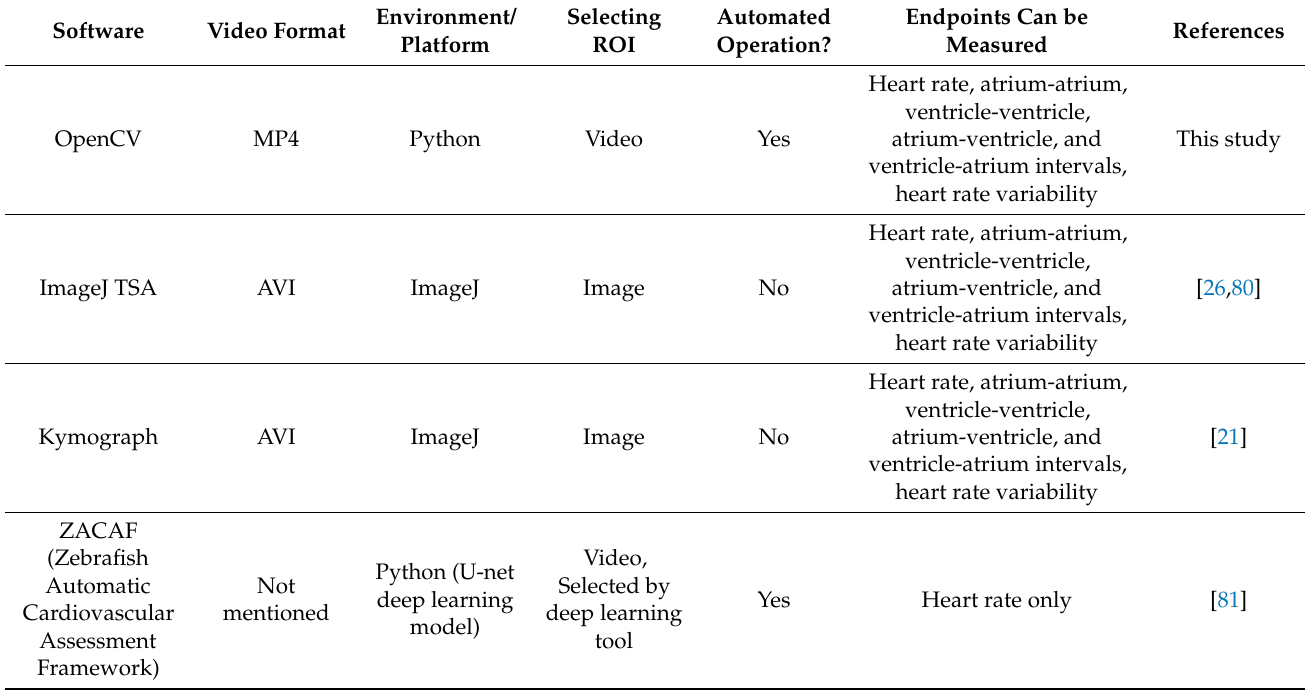
Table 1. Comparison of OpenCV and other methods for heart rate and cardiac rhythm measurement in